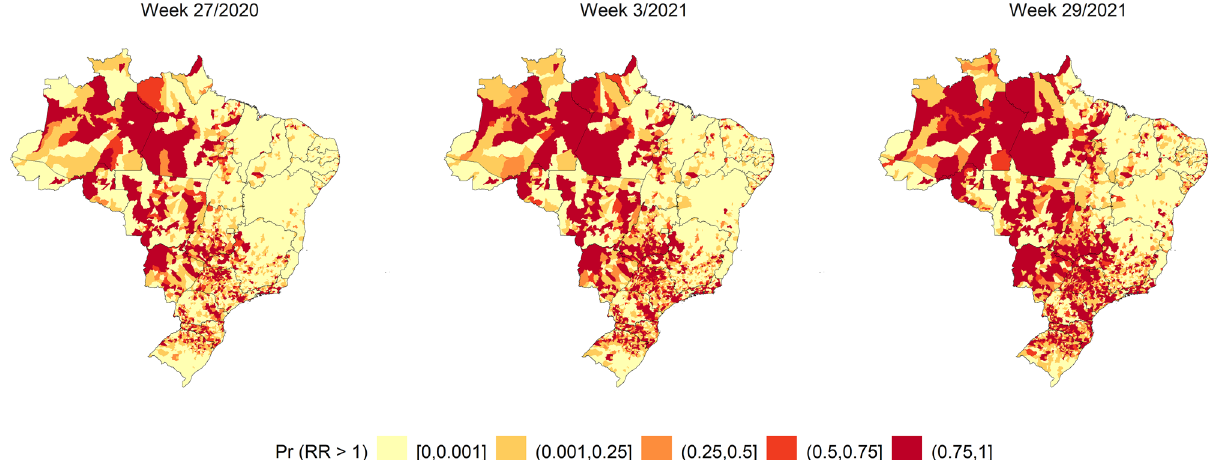
Figure 7. Relative risk of the ZINB spatial–temporal regression models for the standardised incidence ratio of severe acute respiratory syndrome coronavirus 2 in weeks 15/2020, 30/2021, 45/2020, 7/2021, 22/2021, and 38/2021. The map was generated using public domain shapefiles provided by the Brazilian Institute of Geography and Statistics (https:// geoftp. ibge. gov. br/ organ izacao_ do_ terri torio/ malhas_ terri toria is/ malhas_